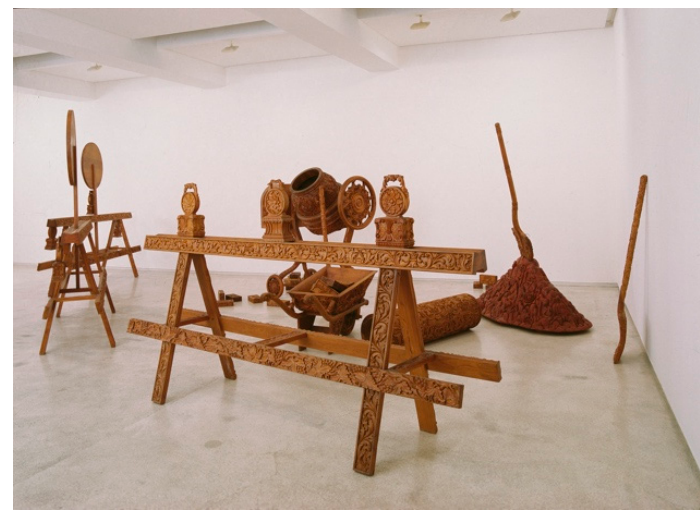
Figure 7. Módulo, “Wim Delvoye, Chantier (Installation)”, 1992. © Módulo—Centro Difusor de Arte. Figure 7. M ó dulo, “Wim Delvoye, Chantier (Installation)”, 1992. © M ó dulo—Centro Difusor de